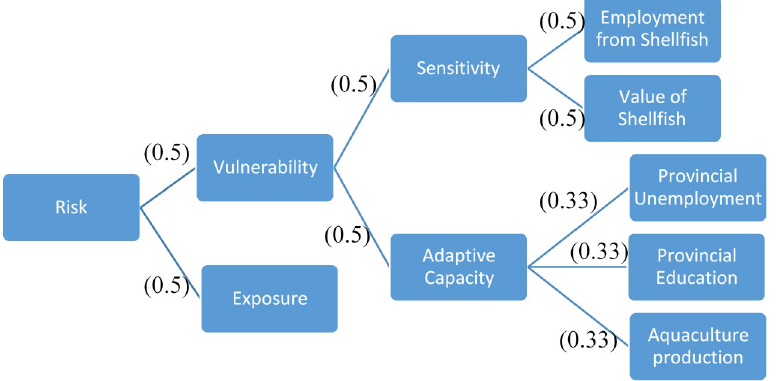
Fig 4. Framework for the impact index demonstrating relationship between components. Elements at each branch are equally weighted to other items at the same level as indicated by bracketed numbers.